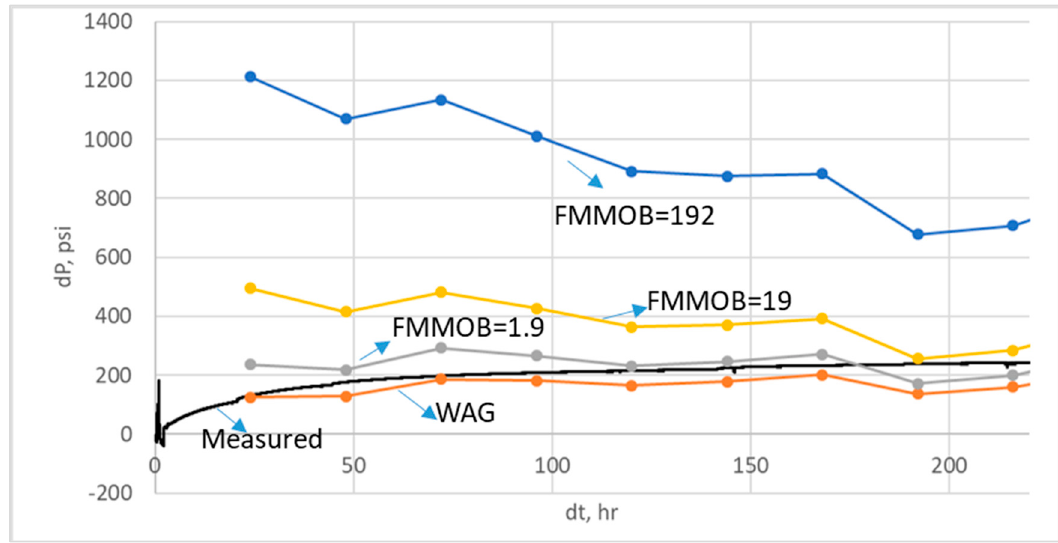
Figure 12. Simulated transient pressures of CO 2 injection during Cycle 2 with different foam strength parameters.